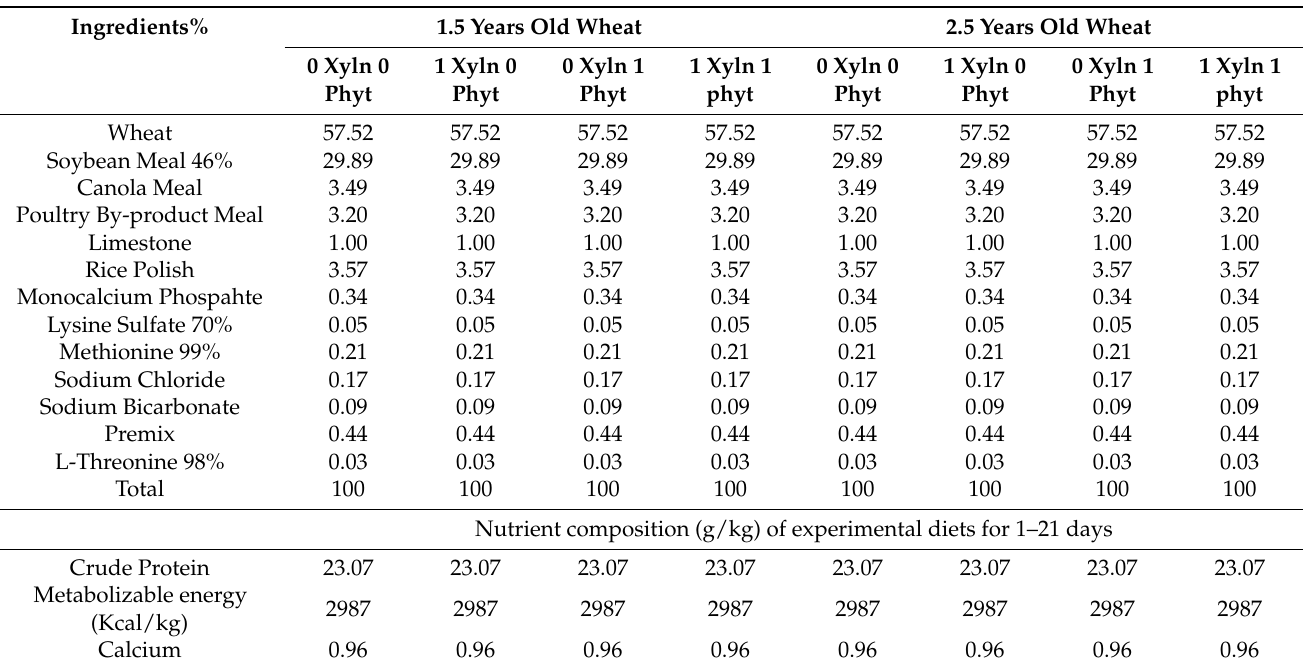
Table 1. Ingredients composition of experimental diets (% inclusion level) for starter